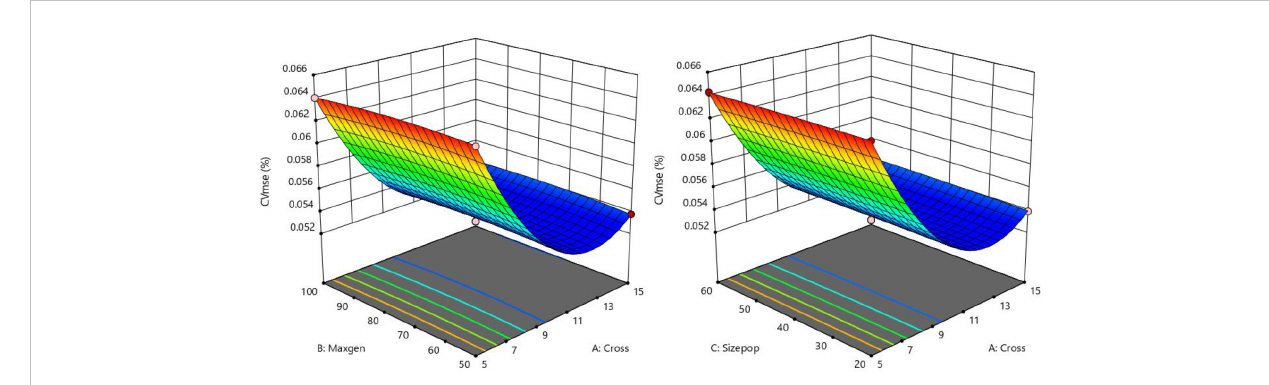
FIGURE 10 Response surface plot for interactions between three variables on CVmse for PSO-SVM models of Dahurian larch.